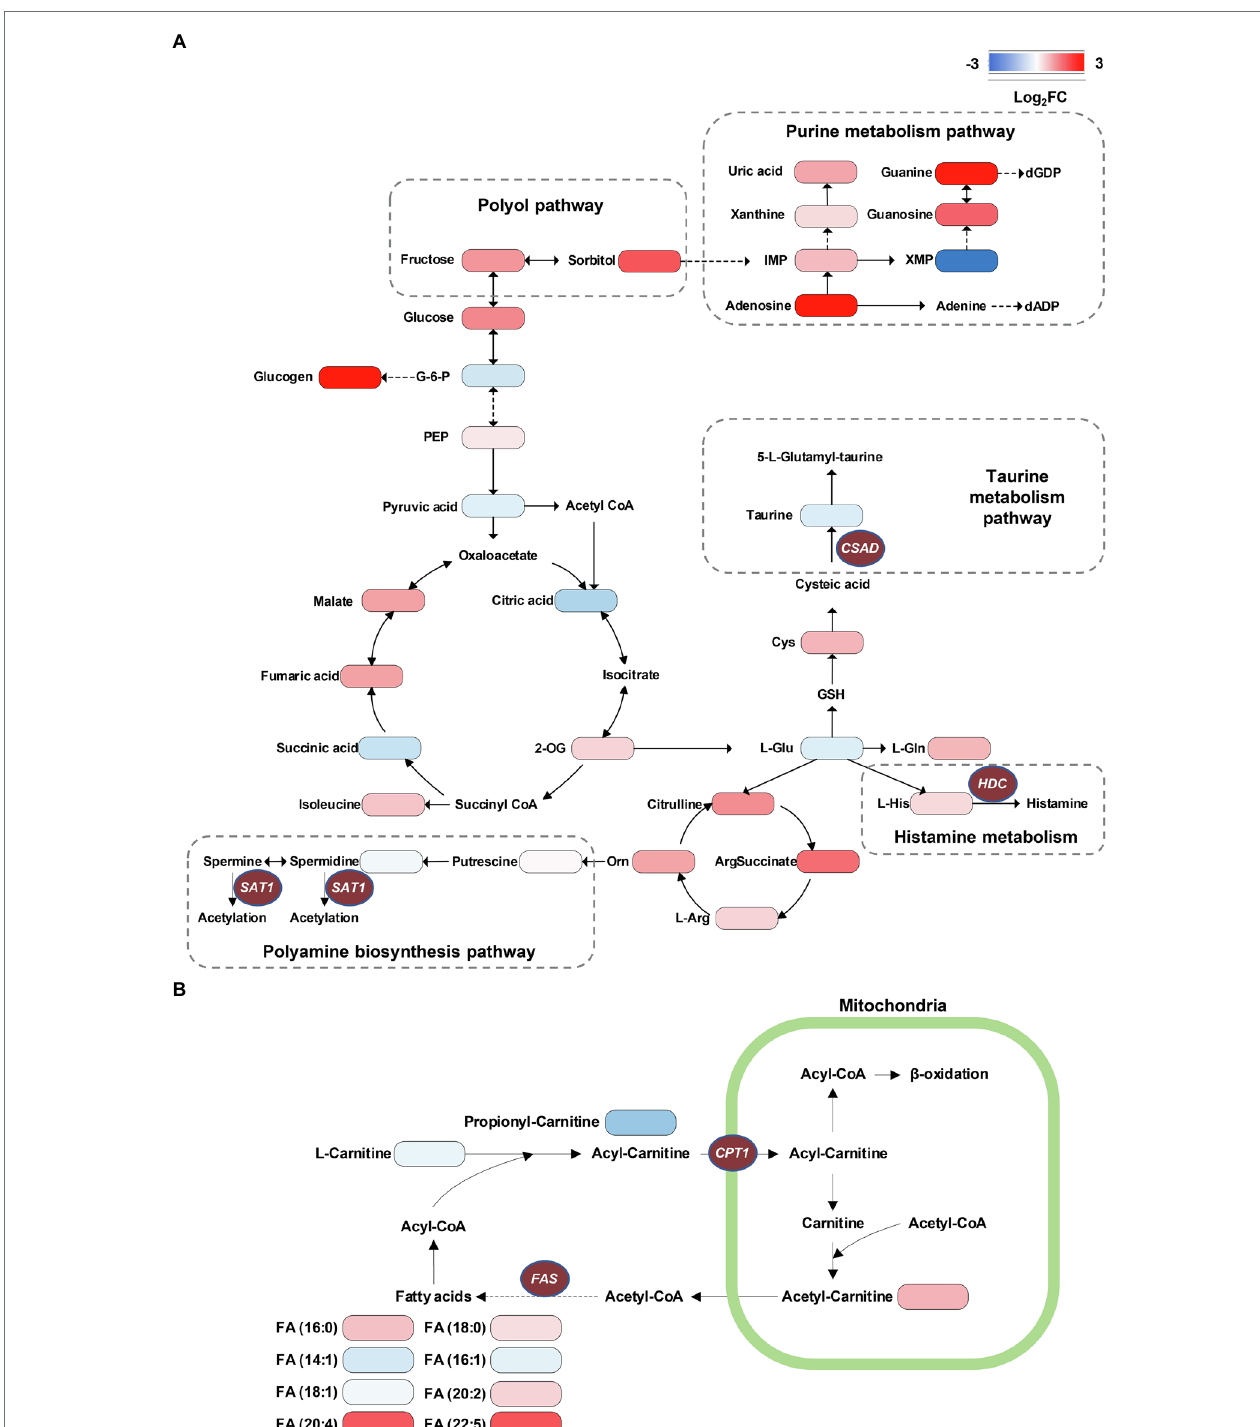
FIGURE 7 | Visualization of metabolome data on the energy metabolic pathway map. (A) Accumulation of TCA cycle metabolites, taurine consumption, spermidine consumption, accumulation of polyol pathway metabolites, and accumulation of purine metabolism pathway metabolites can be recognized in db/db compared with db/m mice. (B) The alternations of long-chain saturated and polyunsaturated fatty acids are presented. The brown ellipses represent rate-limiting enzymes that regulate specific metabolic pathways. G-6-P, glucose-6-phosphate; PEP, phosphoenolpyruvate; 2-OG, oxoglutarate; IMP, inosinic acid; XMP, xanthylic acid; dGDP, 2 ' -deoxyguanosine 5 ' -diphosphate; dADP, 2 ' -deoxyadenosine 5 ' -diphosphate; L-Gln, L-glutamine; L-Glu, L-glutamate; GSH, glutathione; Cys, cysteine; L-Arg, L-arginine; Orn, ornithine; HDC, histidine decarboxylase; CPT1, carnitine O-palmitoyl-transferase 1; FAS, fatty acid synthase; SAT1, Spermidine/spermine N1-acetyl transferase 1; and CSAD, sulfinoalanine